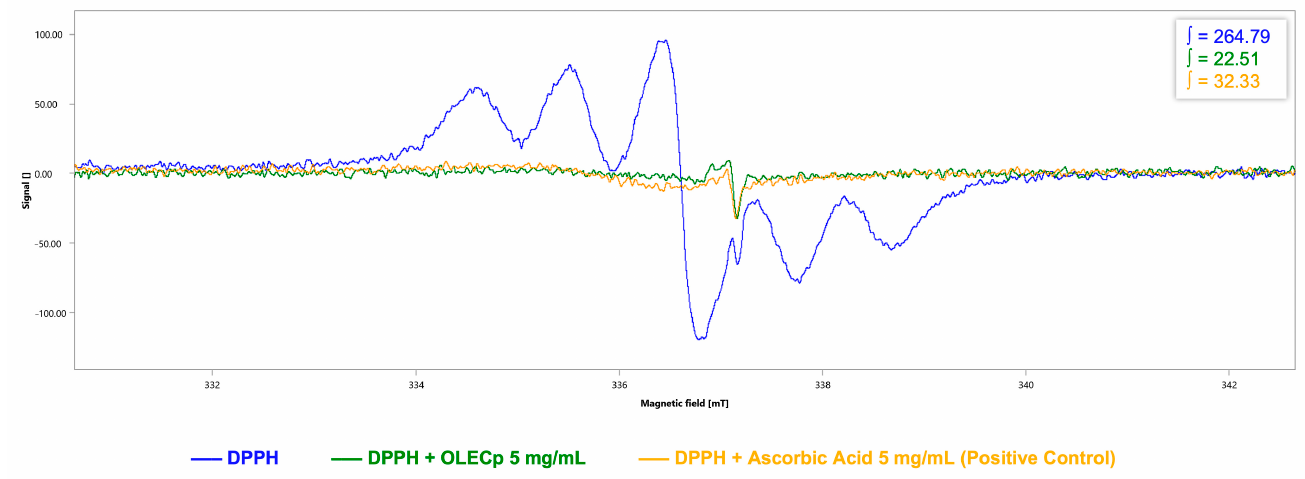
(cid:82) ) of DPPH in the absence (blue)